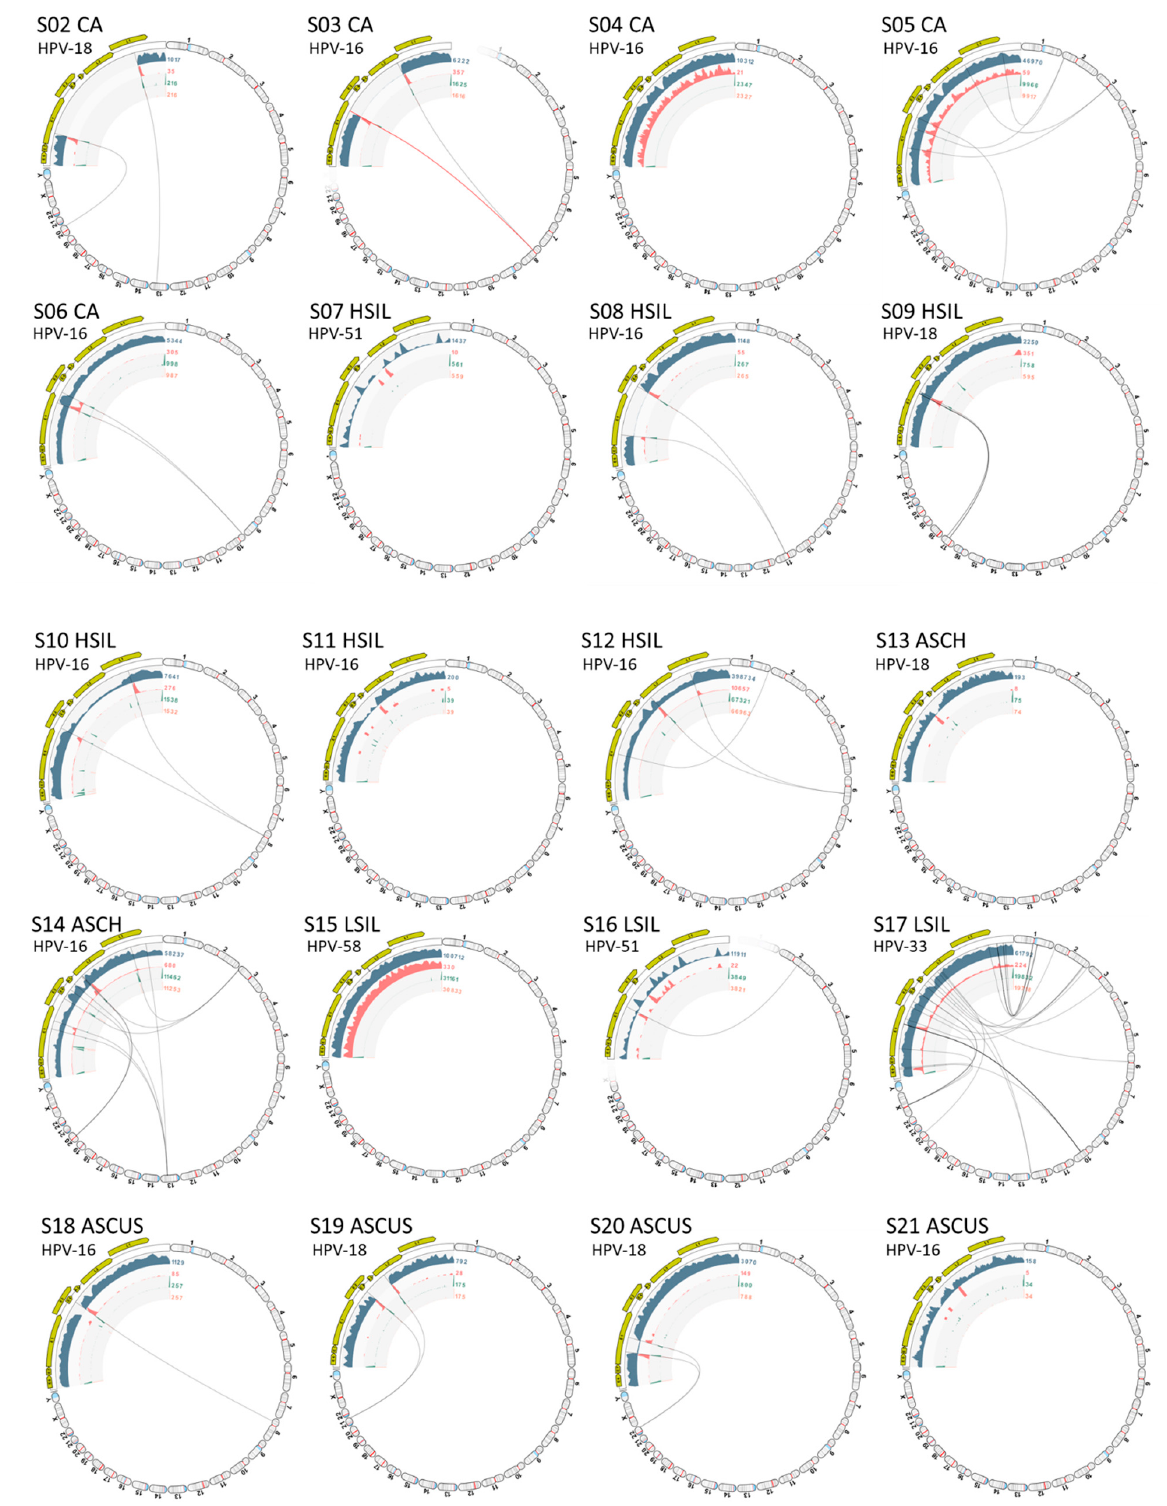
Figure 4. Viral Integration Site (VIS) circular plots. Collage of VIS circular plots for samples (S02 to S21) in chromosome view. Virus-host integration linkages manifested as chimeric reads are designated by the bi-directional curvilinear lines. For S16, HPV-90 and -51 were integrated in chromosomes 7 and 2, respectively (only the HPV-51/chr. 2 plot is shown). The dynamic functions (rotate and zoom) of the VIS circular plot are presented in Supplementary Video S1.